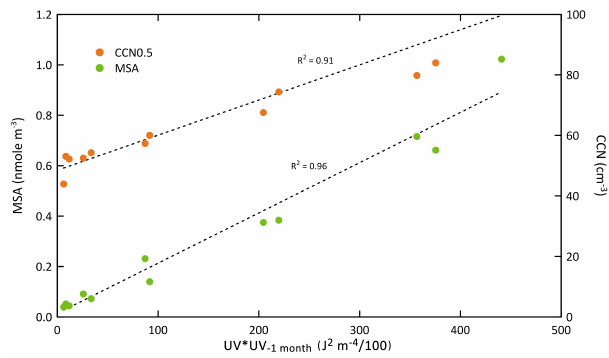
Figure 10. MSA and CCN0.5 dependence on UV*UV-1